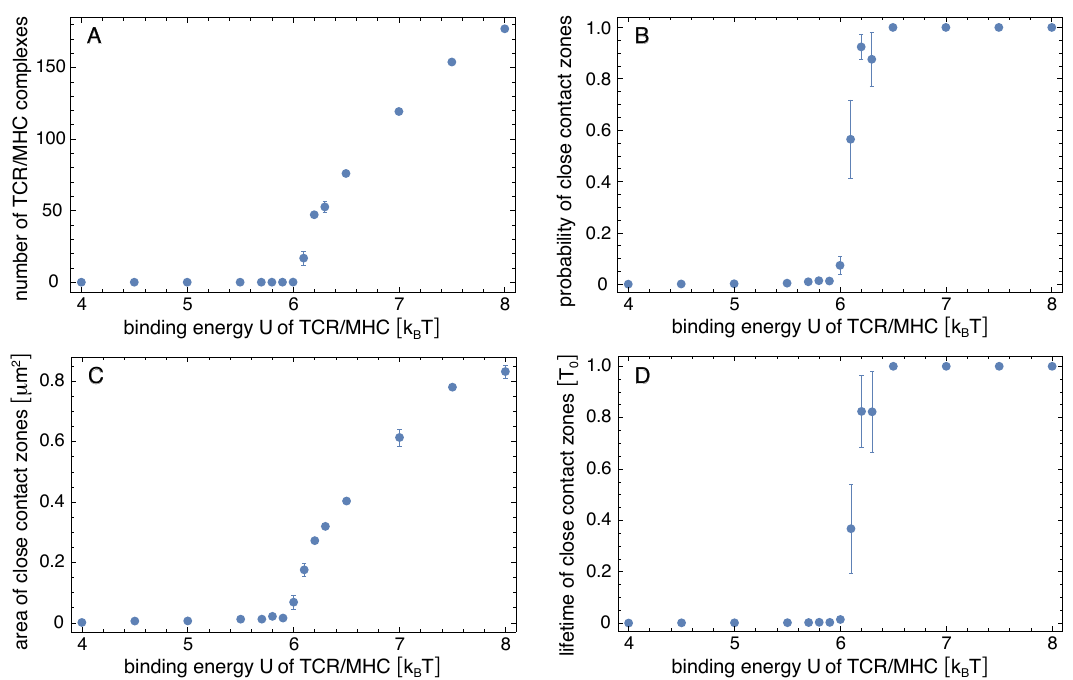
Figure 2. Simulation results in the adhesion scenario with only one type of peptide-MHC complexes. The ( A ) number of TCR/peptide-MHCs complexes, and the ( B ) probability, ( C ) area, and ( D ) lifetime of close-contact zones are average values obtained from the equilibrated simulation trajectories of length T o = 1.6 × 10 8 t o where t o is the time corresponding to one MC simulation step. The errors are calculated as the error of the mean for six independent trajectories at each value of the binding energy U of the TCR/peptide-MHC